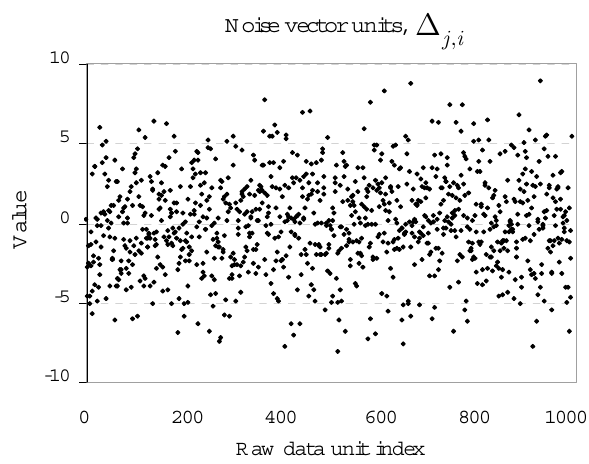
Figure 10. The distribution of the units of the noise vector of the Gaussian quantum channel. The noise affects the combined state in the phase space and the resulting raw data units on Bob’s side.